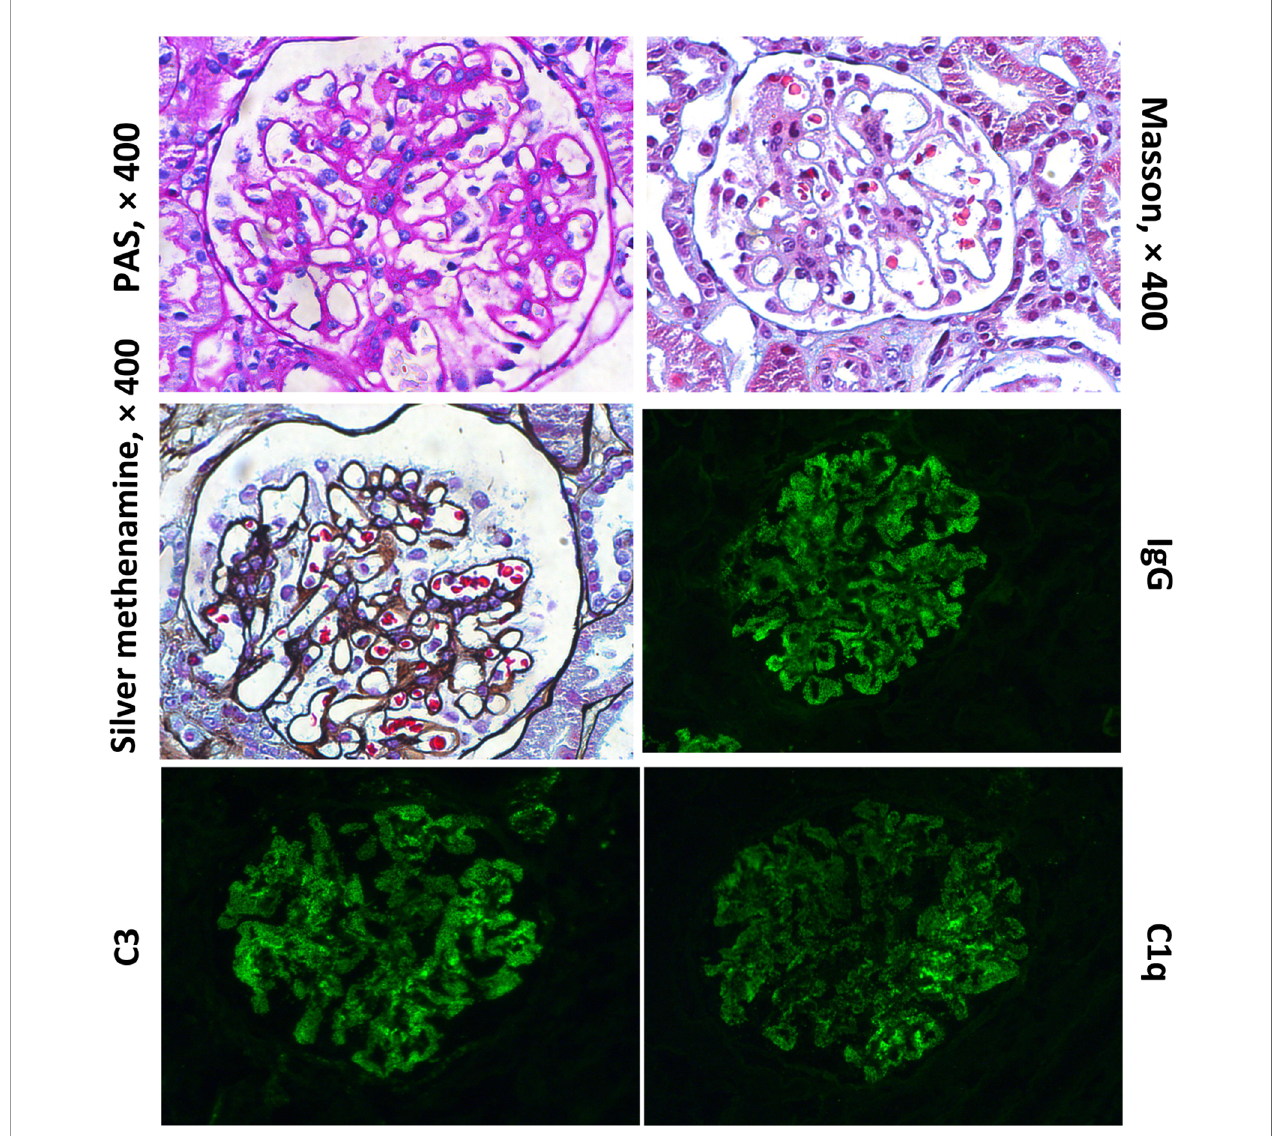
FIGURE 3 | Histological fi ndings from renal biopsy specimen. Renal biopsy showed one segmental glomerulosclerosis on 50 glomeruli with “ full house ” pattern depositions within capillary loops.